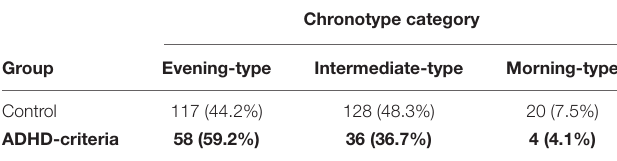
TABLE 2 | Self-reported chronotype by ADHD